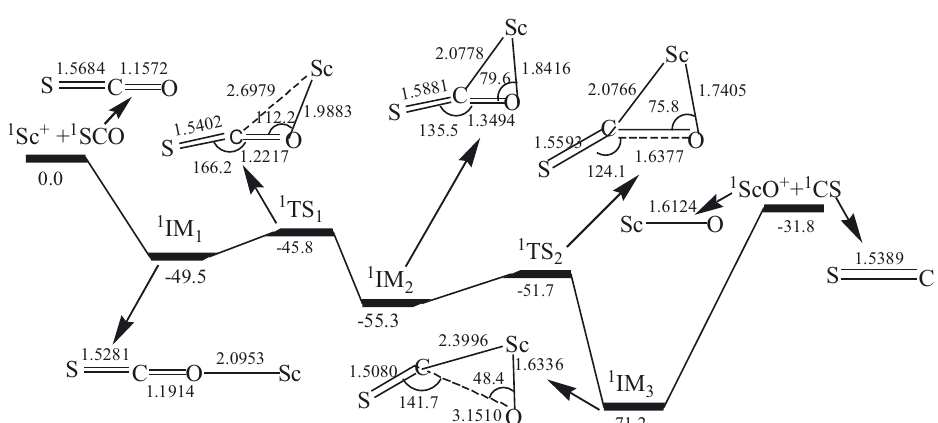
Figure 1. Potential energy diagram for the reaction steps of singlet Sc + with SCO along the C-O bond activation branch calculated at the UB3LY- P/6-311+G* level. Relative energies are given in kcal/mol. Geometric structures (bond lengths in Å and bond angles in deg.) of required species optimized at the UB3LYP/6-311+G* level of theory are also